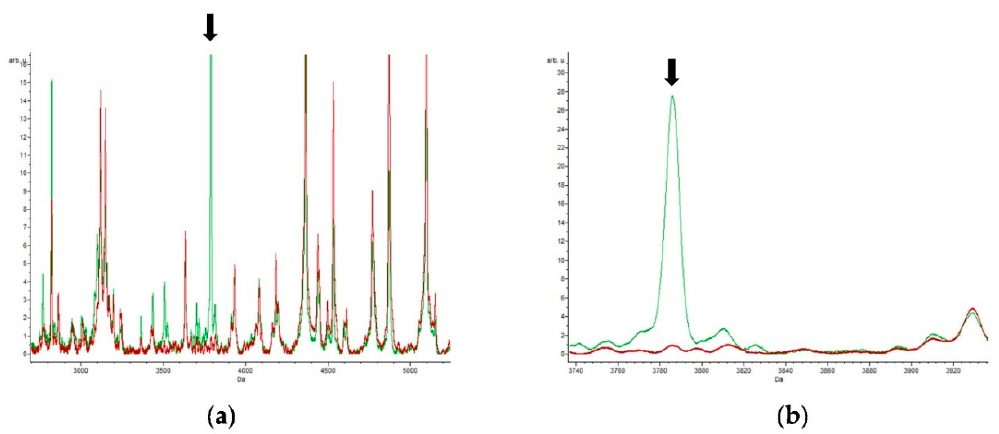
Figure 6. Ciprofloxacin antibiotic: ( a ) spectrum obtained in the presence of ciprofloxacin (green) and without antibiotic (red); ( b ) a detail of the main peak of interest at 3785.80 m/z .